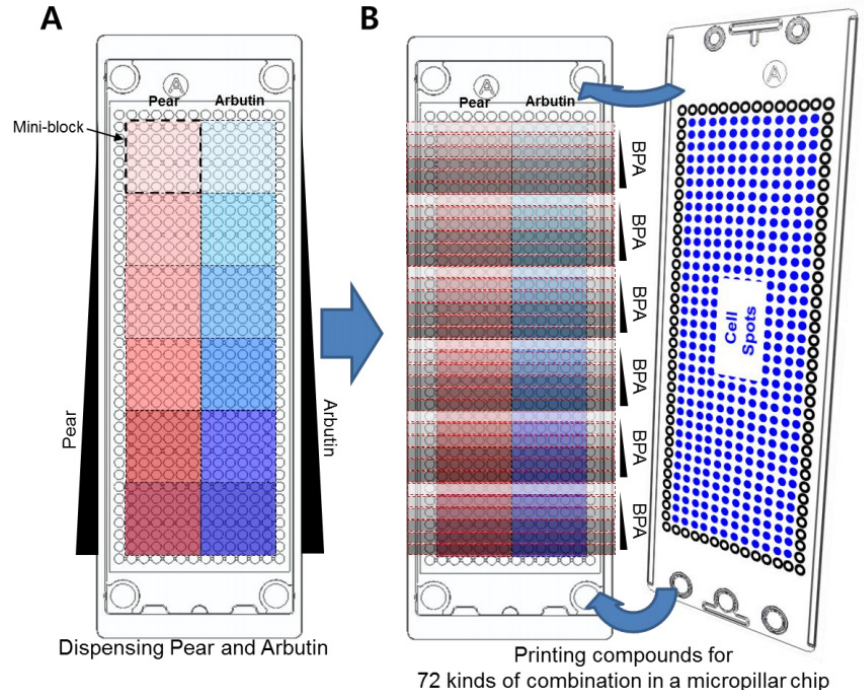
Figure 2. Layout of compound printing in the microwell chip to generate 72 combinations of compound test conditions in 12 mini ‐ blocks: ( A ) Printing of six different concentrations of Korean pear extract and arbutin in twelve mini ‐ blocks in the microwell chip (one concentration of pear extract or arbutin per mini ‐ block). ( B ) Subsequent printing of six different concentrations of BPA in each mini ‐ block in the microwell chip, followed by sandwiching the micropillar chip with human liver cells (Hep3B or HepG2 human hepatoma cell lines) in alginate.